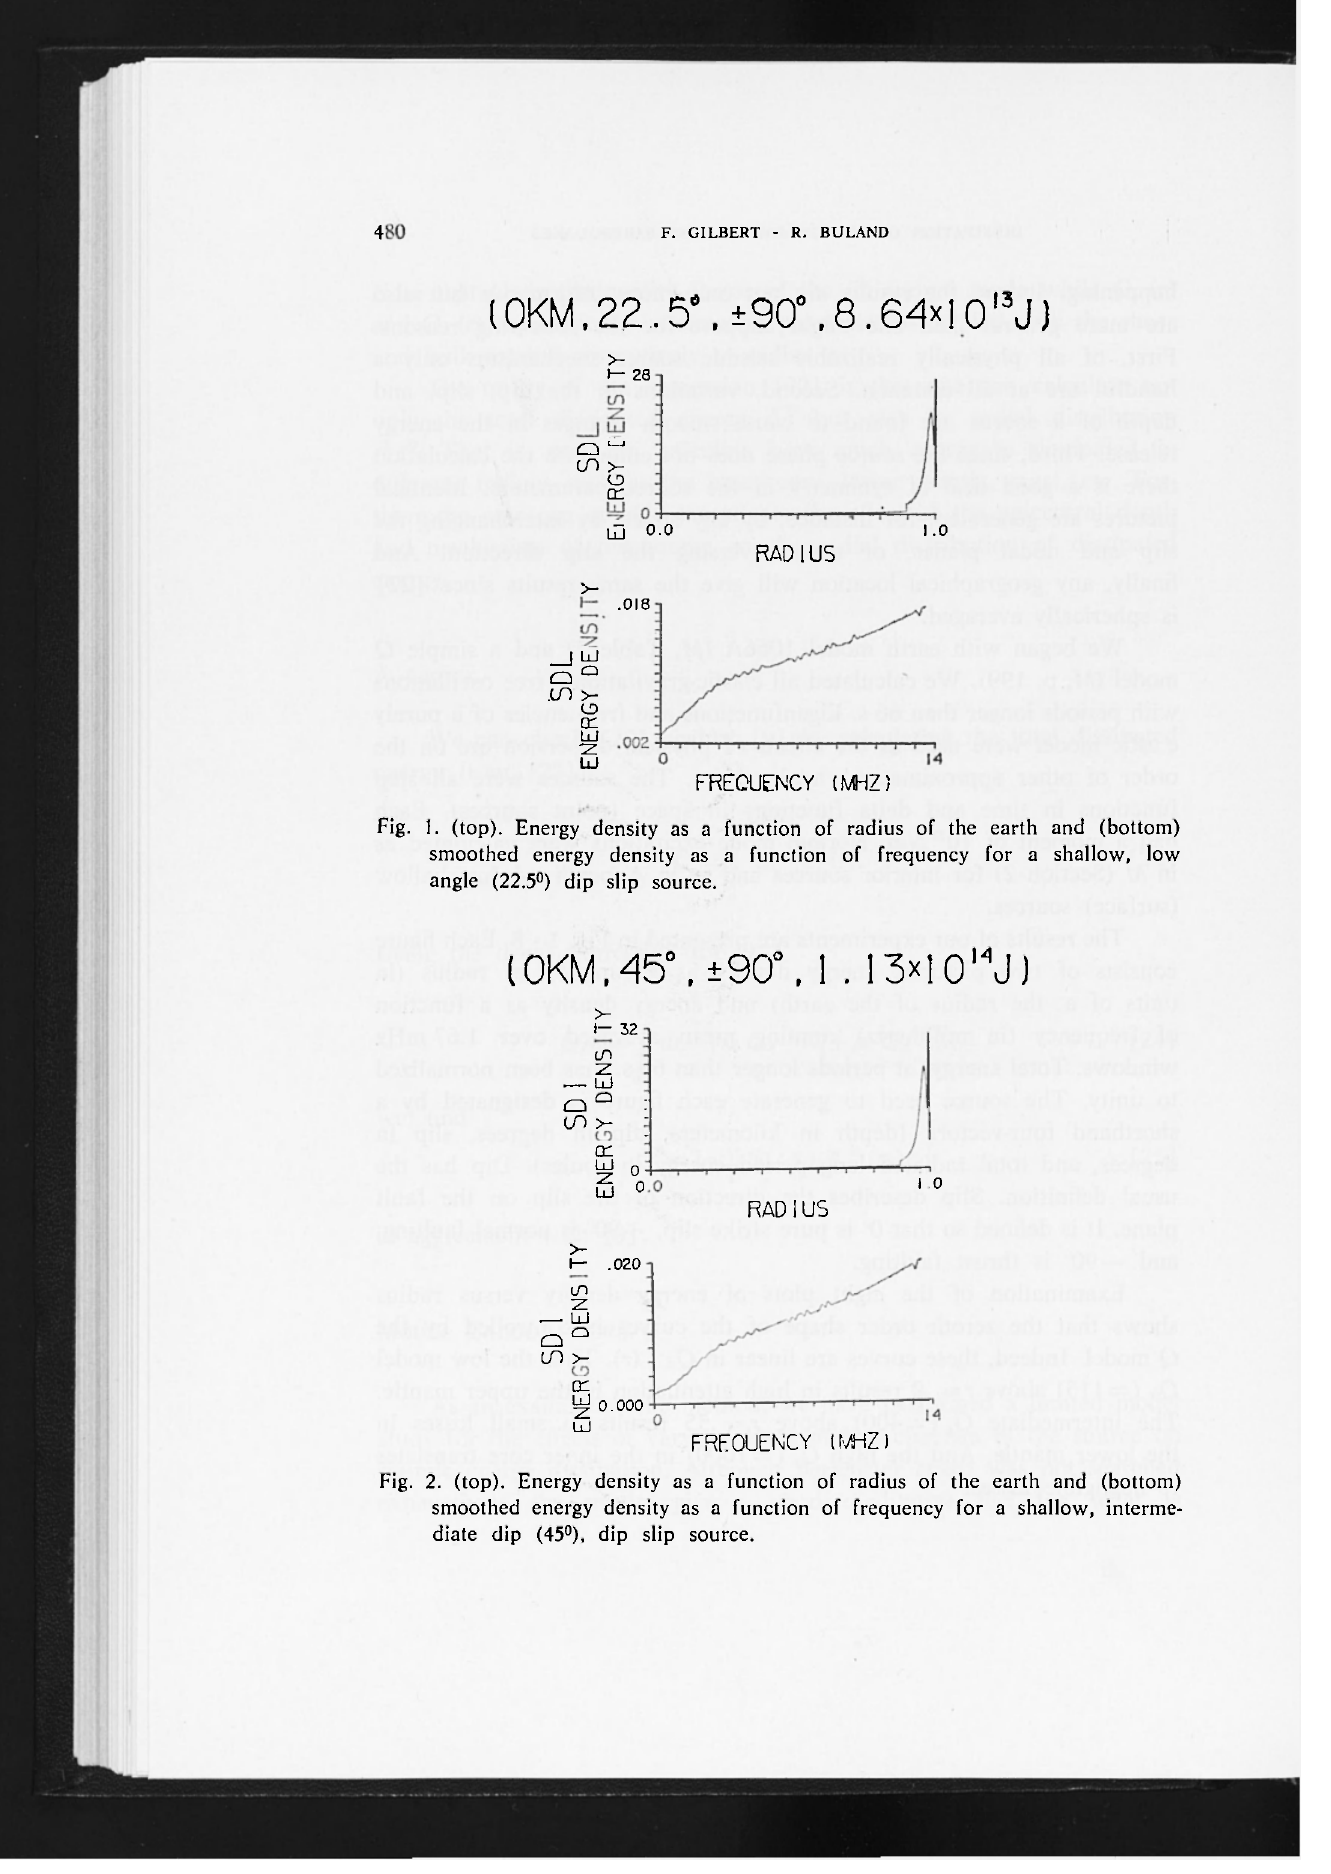
Fig. 2. (top). Energy density as a function of radius of the earth and (bottom) smoothed energy density as a function of frequency for a shallow, interme- diate dip (45°), dip slip